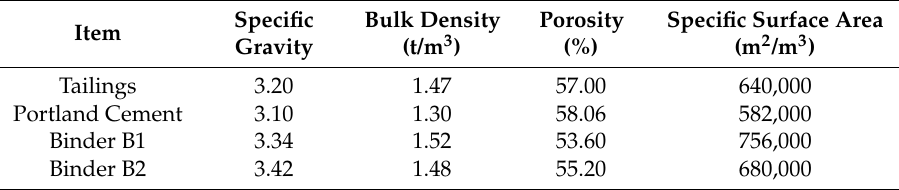
Table 3. Physical properties of the filling material.